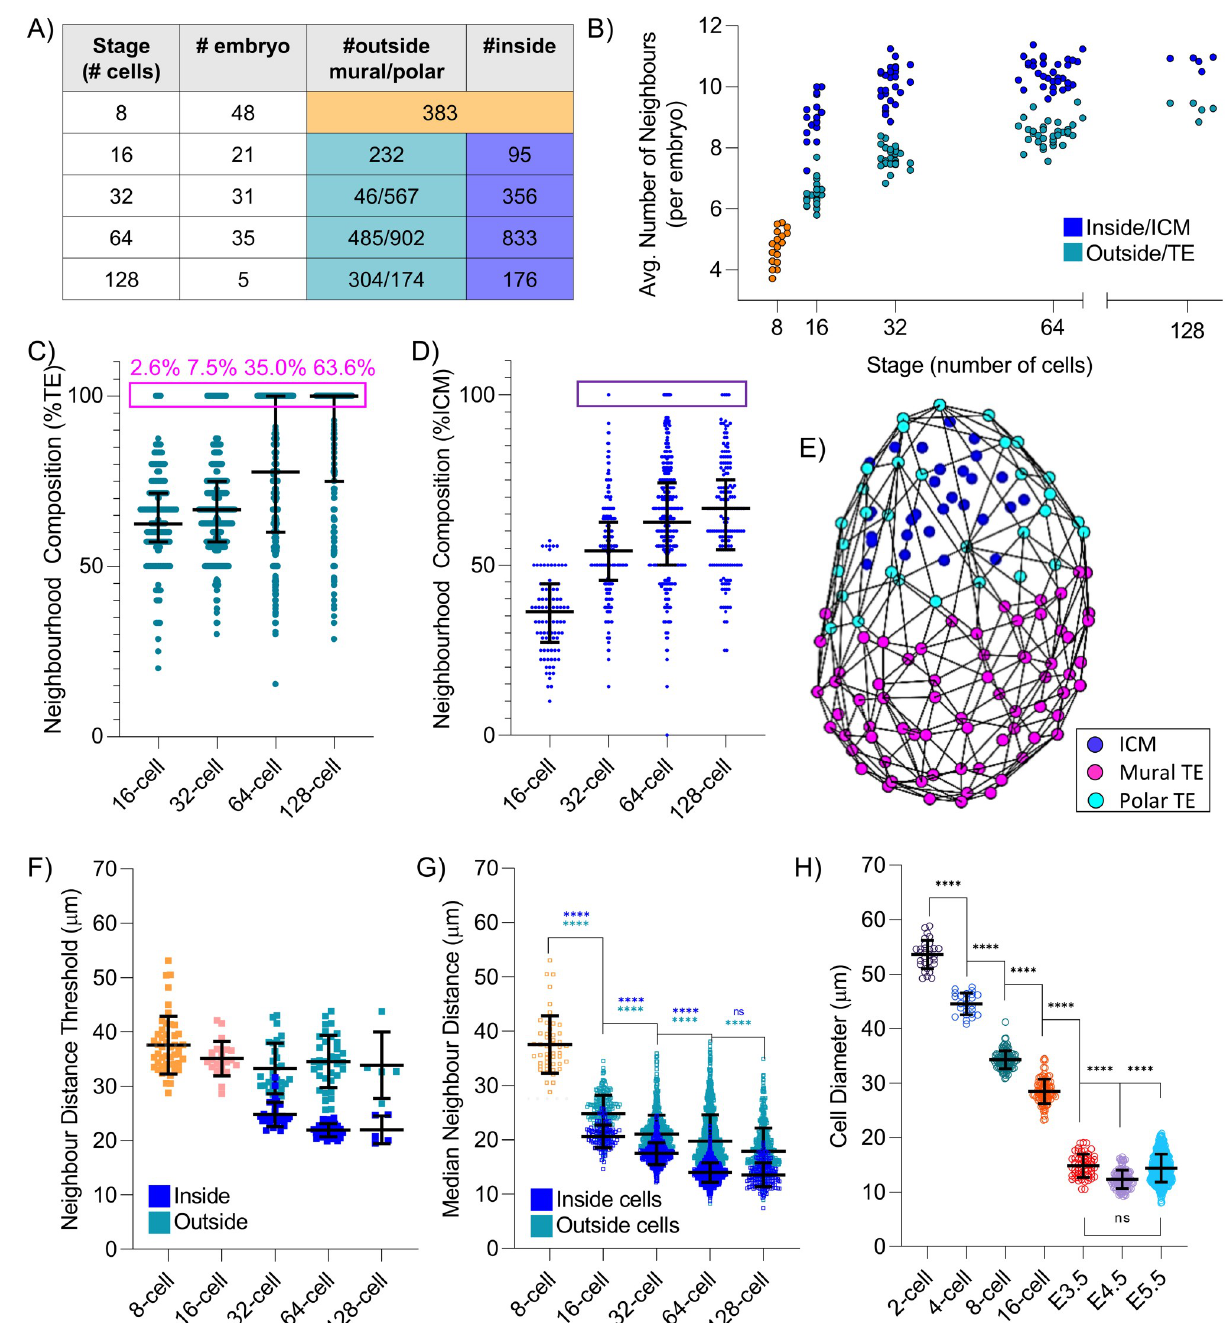
Fig 2. Assessment of the neighbourhood of preimplantation embryos between the 8-cell stage and 128-cell stage using the IVEN pipeline. (A) Number of analysed embryos and cells per developmental stage that was assessed using IVEN. (B) Average number of neighbours of outside and inside cells per embryo. Outside cells shown to typically have fewer neighbours than inside cells. (C) Neighbourhood composition of outside cells presented using the percentage of neighbours that were also outside cells. Outside cells shown to exhibit a subpopulation of cells with 100% of their neighbours also outside cells (pink box). (D) Neighbourhood composition analysis of inside cells, as described by the percentage of neighbours that were also inside cells. General increase in the percentage of inside cell neighbours that are also inside cells. Inside cells shown to exhibit a subpopulation of cells with 100% of their neighbours also inside cells (purple box). (E) Embryo schematic of a 128-cell stage embryo with mural versus polar TE cells marked, as classified by IVEN. (F) IVEN calculated thresholds for each developmental stage. Each marker is representative of an embryo threshold. (G) Median distance to neighbours for inside and outside cells. (H) Change in average cell diameter with developmental stage. Cell diameter decreases significantly at all stages until E4.5 where cells then appear to increase in size at the E5.5 stage. Cells appear of similar diameters at E3.5 and E5.5. Data underlying this figure can be found on the public GitHub repository https://github.com/jessforsyth/forsyth-et-al-2021. ICM, inner cell mass; IVEN, Internal Versus External Neighbourhood; TE, trophectoderm.